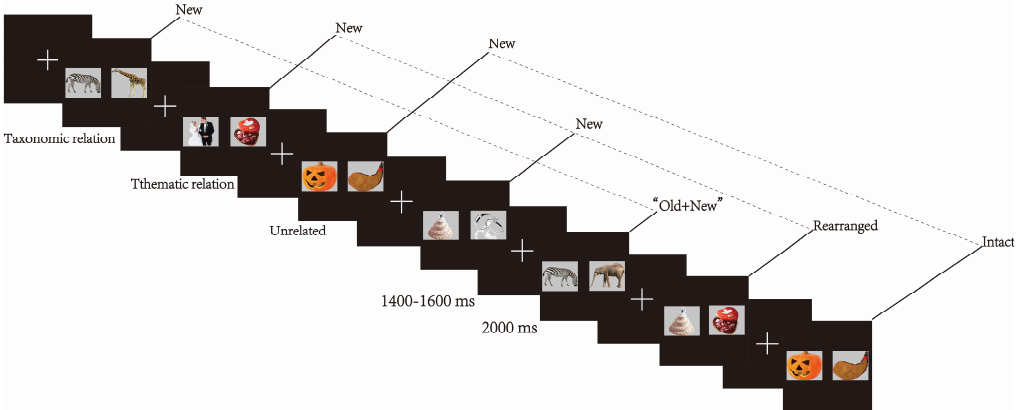
Figure 1. Schematic illustration of the experimental procedure with exemplars of picture pairs, illuminating the function of semantic relation by pair type. The procedure is designed via a continuous recognition paradigm. Participants are presented with a series of picture pairs and informed to di ff erentiate among the four types of pairs: intact, rearranged, “old + new”, and new.